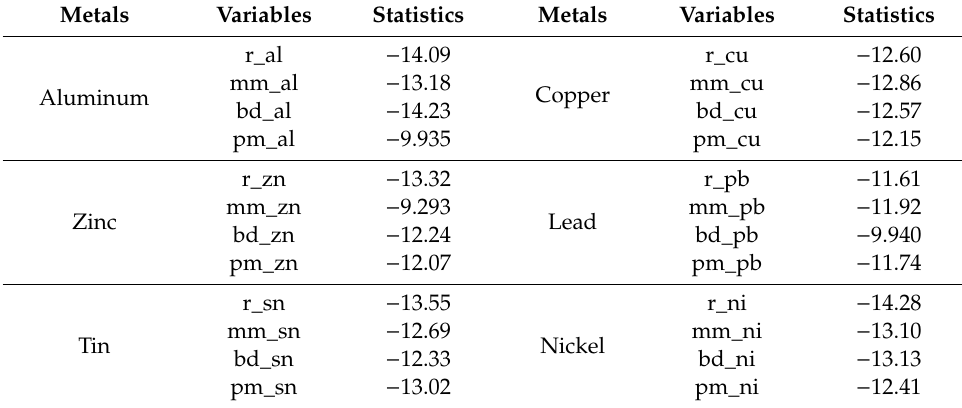
Table 1. Unit root test